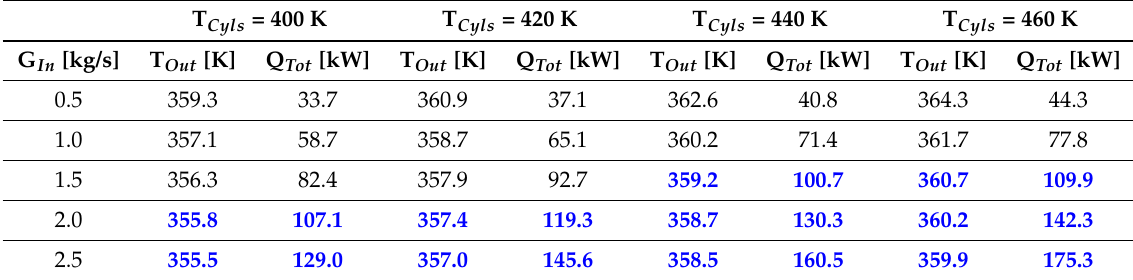
Table 2. Mass-averaged outflow temperature and total transferred heat flux tabulated as a function of G In and T Cyls for the single-inlet